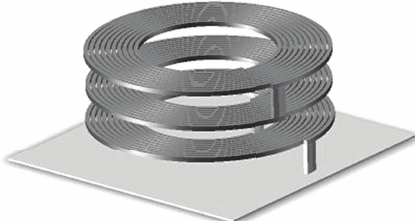
Figure 1: Three-dimensional rendering of a multilayered, stacked inductor (MLSI).